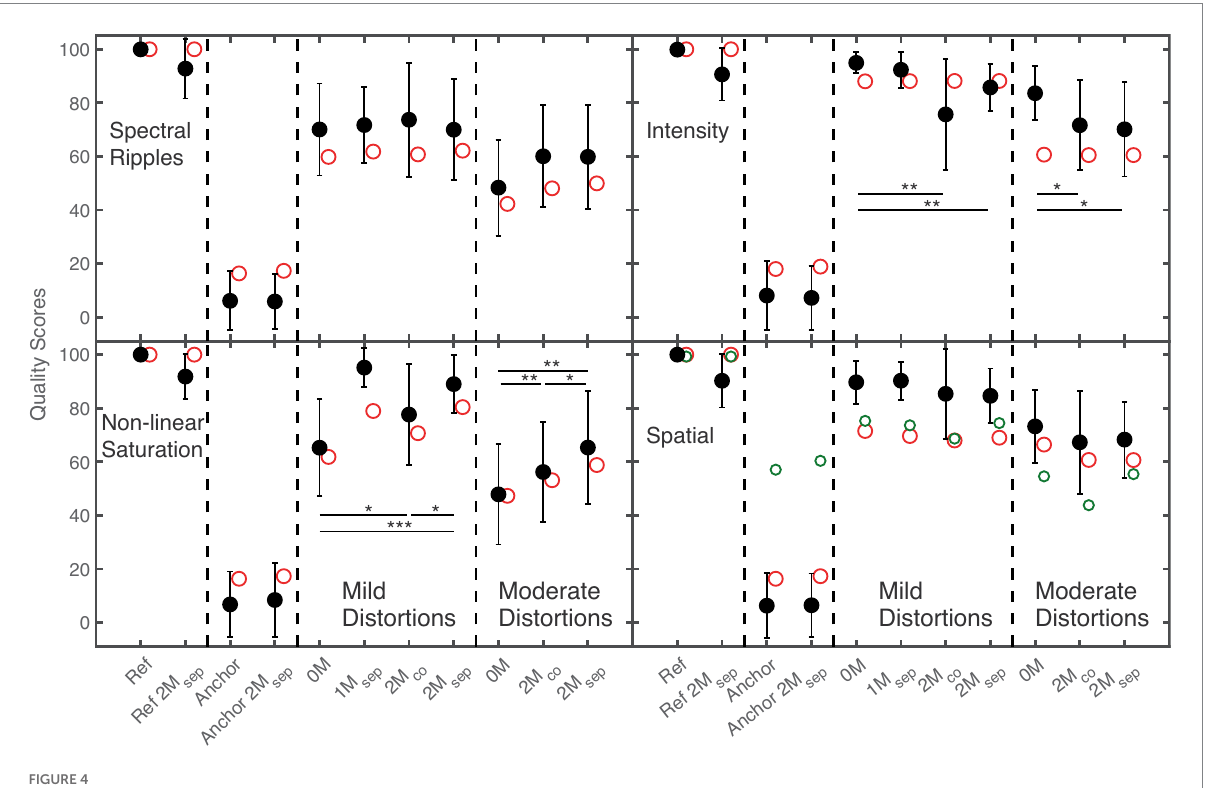
FIGURE 4 Quality ratings (black filled symbols) for the speech target with spectral ripples, intensity distortion, non-linear saturation, and spatial distortions in the Small room as a function of the masker configuration. Ref and Anchor refers to the hidden reference and the anchor signals. 0 M indicates no masker. In the configuration 1M sep , the ISTS masker was presented at − 45 ° azimuth relative to the viewing direction of the listener. In configurations 2M co , and 2M sep the ISTS and music maskers were presented at 0 ° , and + − 45 ° azimuth. Statistically significant pairwise comparisons involving masker configurations 0 M, 2M co , 2M sep are indicated by the asterisks. Red and small green open circles refer to GPSM q and BAM-Q